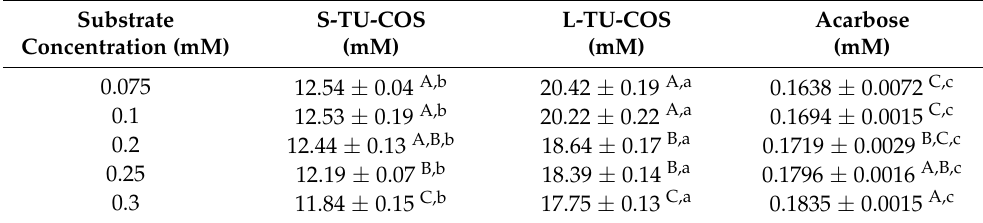
Table 2. The IC 50 values of S-TU-COS, L-TU-COS, and acarbose on α -glucosidase